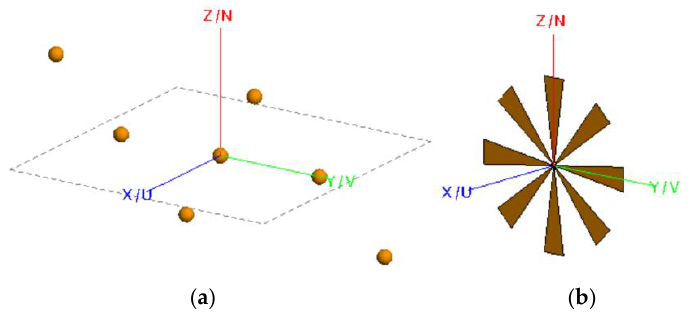
Figure 5. Two kinds of targets used in the simulations: ( a ) Seven extremely small metal points that are arranged in a specific way; ( b ) Metal fan with eight blades.